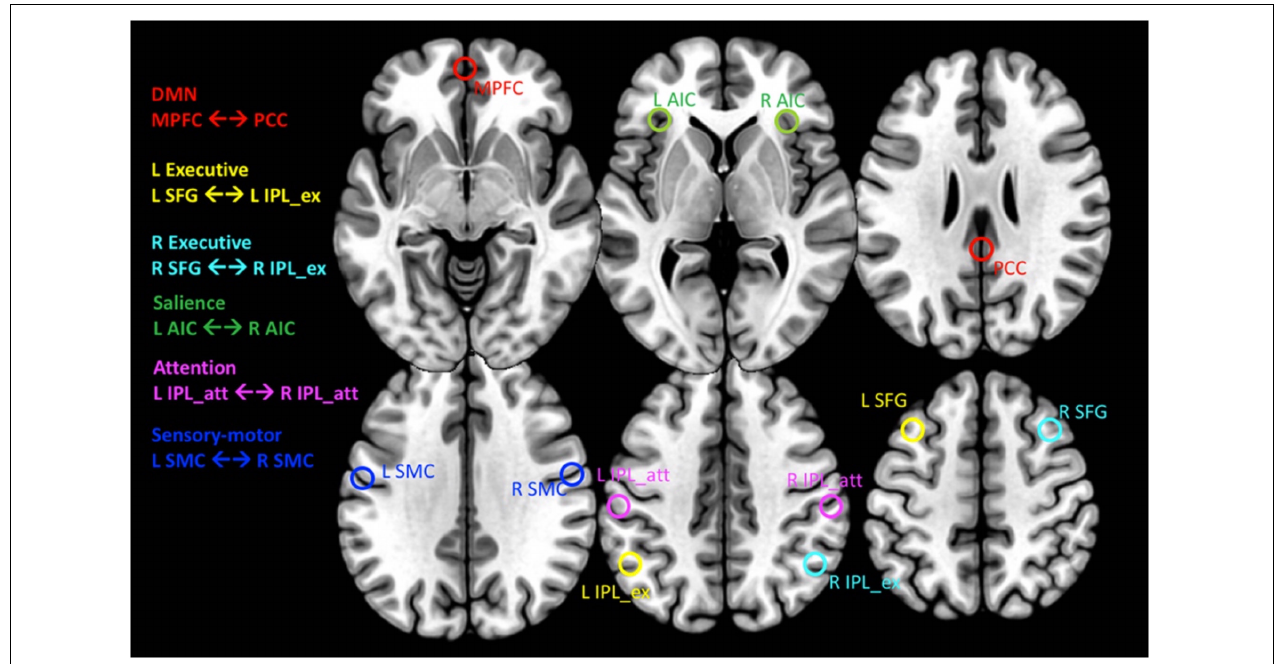
FIGURE 1 | Transaxial planes showing the location of spherical regions in MNI space from where the CMRGlc values and rs-fMRI time series’ were extracted. For MNI coordinates of regions, see text. Red: default mode network (DMN) connecting the medial prefrontal cortex (MPFC) with the posterior cingulate cortex (PCC). Yellow and Cyan: L/R Executive networks, connecting the L/R superior frontal gyrus (SFG) with the anterior portion of the inferior parietal lobe (IPL_ex), respectively. Green: salience network connecting the R/L anterior insular cortex (AIC). Magenta: attention network connecting the L and R posterior portion of the inferior parietal lobe (IPL_att). Blue: sensory-motor cortex connecting the L and R sensory motor cortex (SMC).